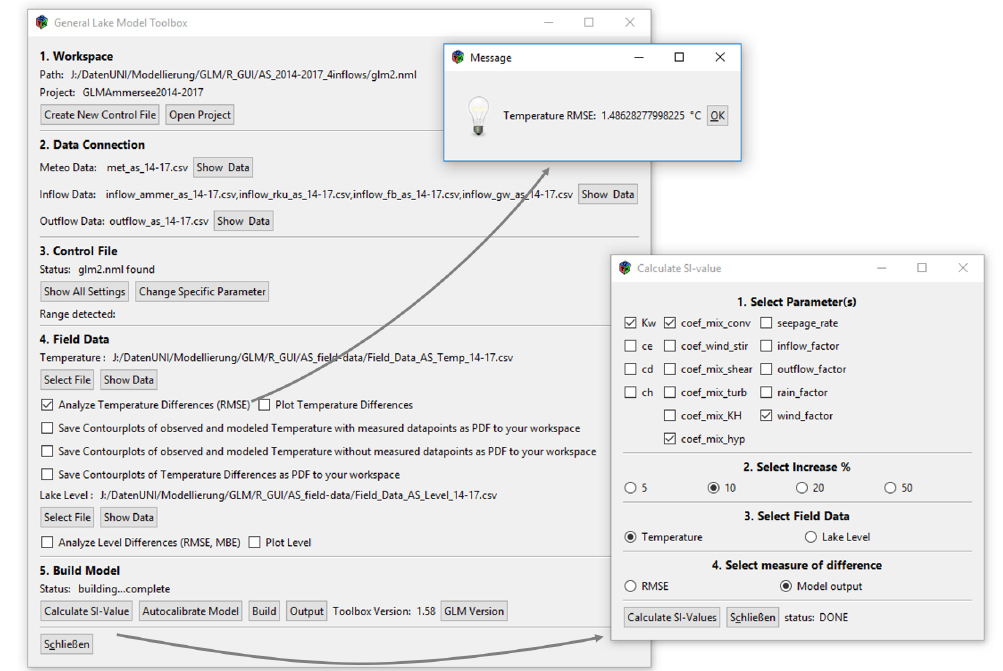
Figure 1. Window-based structure of glmGUI with examples of the submenu “Calculate SI-value” and of the result message “Temperature RMSE” created after a model